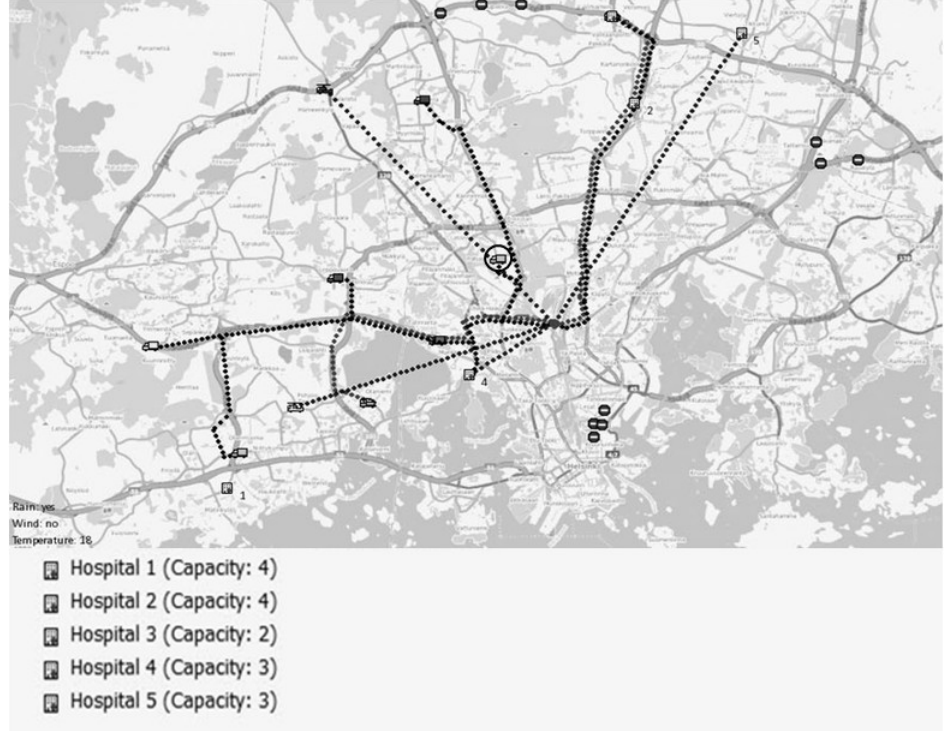
Figure 4. Response actions